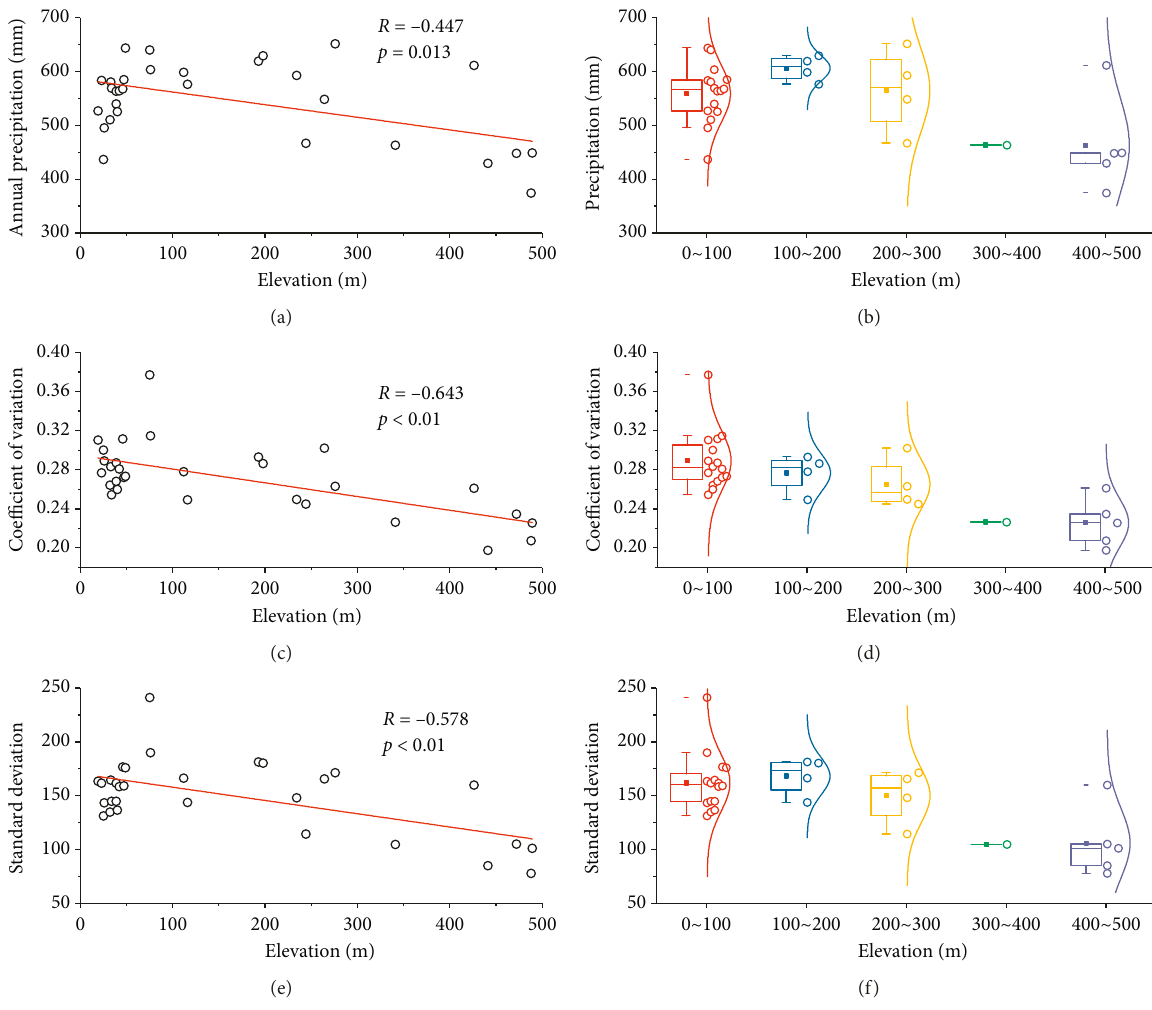
Figure 7: Scatter and box-plots in the correlations between precipitation characteristics and elevation. Solid red line is the linear trend. R signifies the Pearson correlation coefficient for each relationship and p indicates the statistical significance. The solid square means the mean value during the different elevation